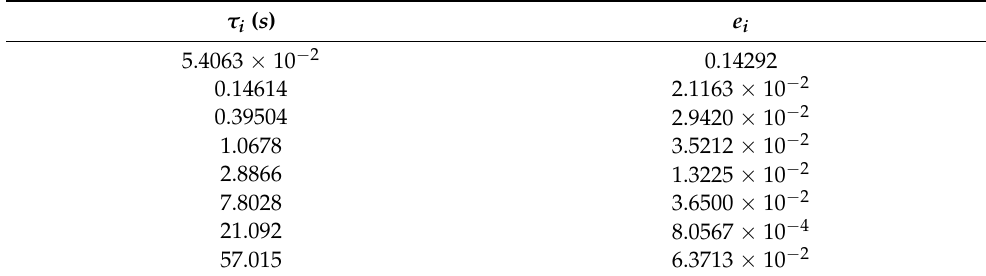
Table 7. Prony series coefficients.